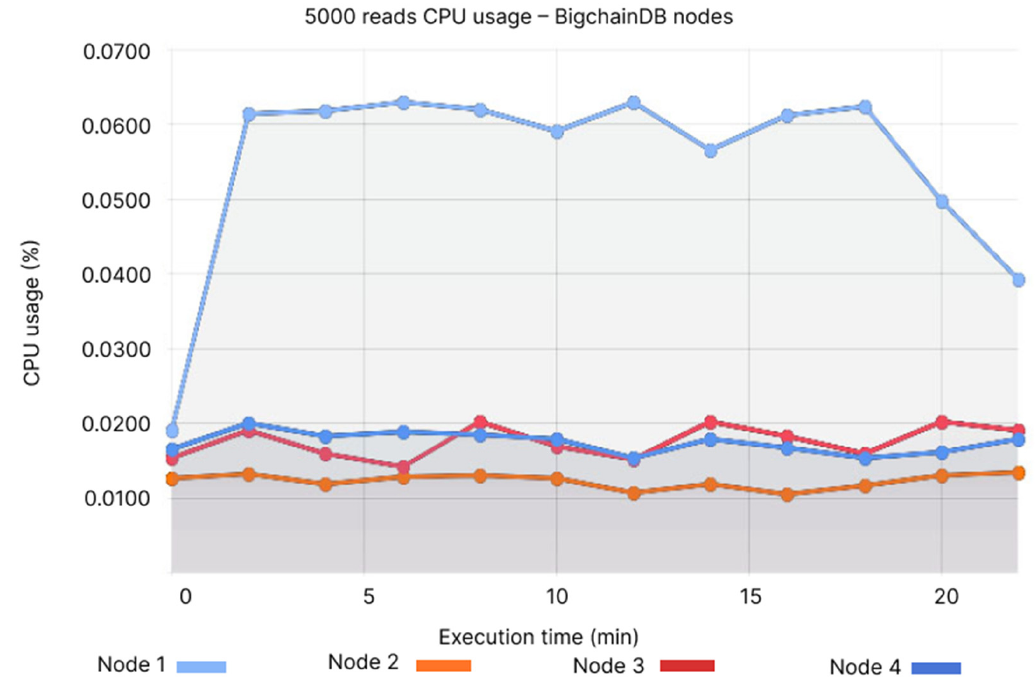
Figure 22. 5000 reads CPU usage—BigchainDB nodes.